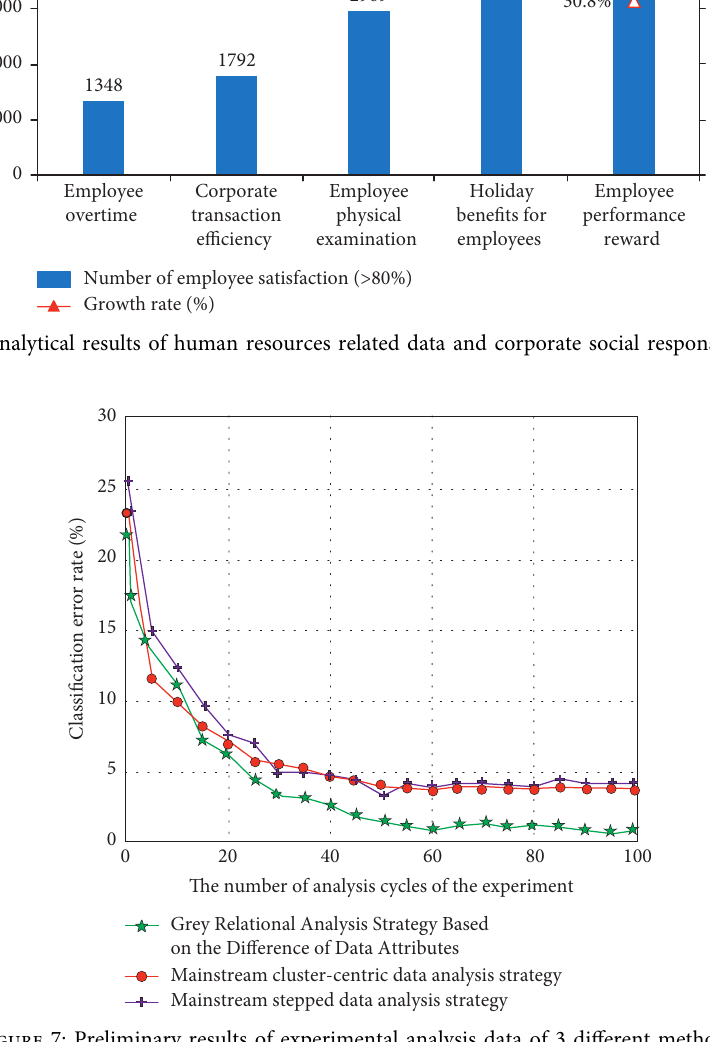
Figure 7: Preliminary results of experimental analysis data of 3 different